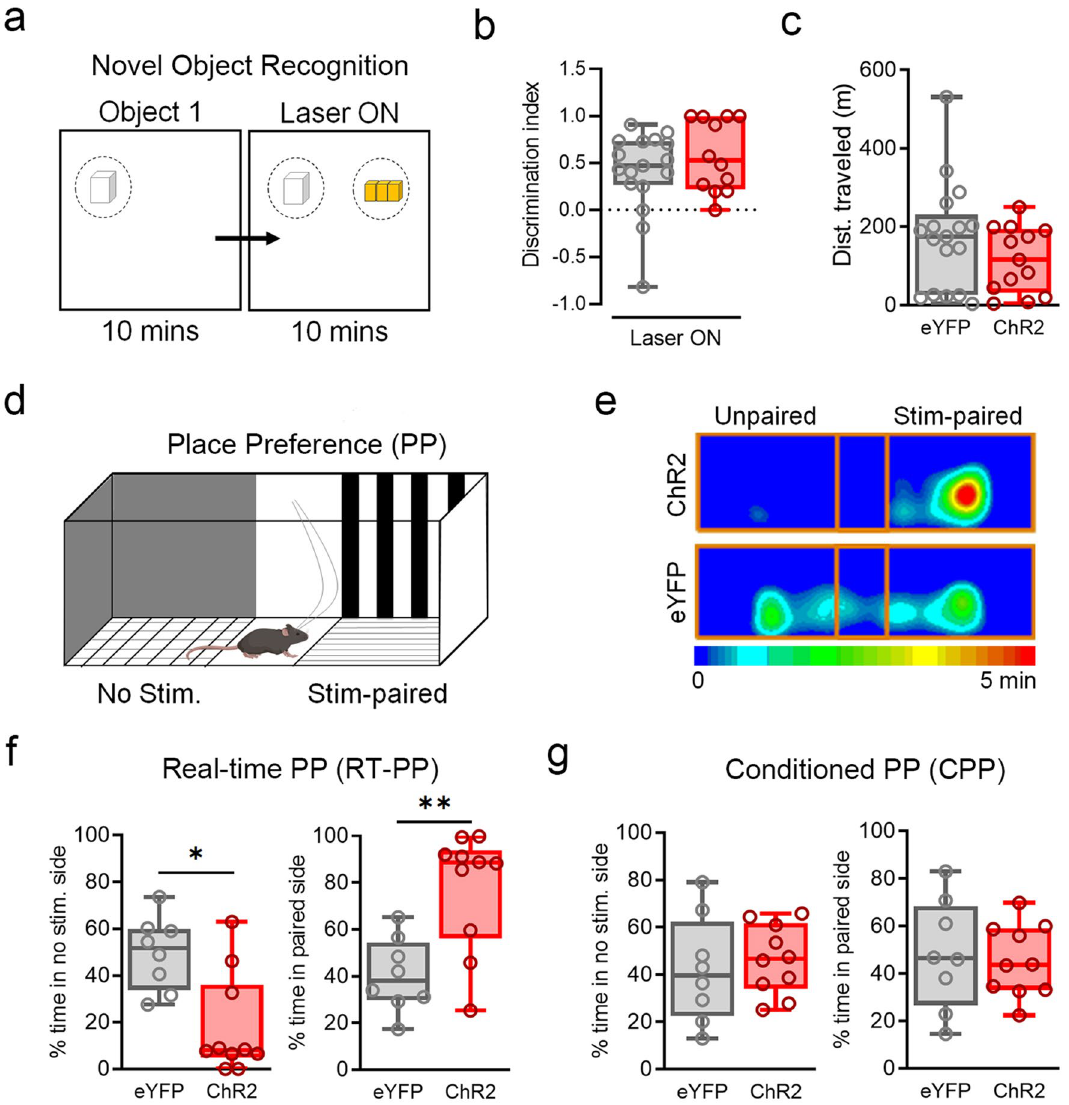
Figure 2. BF GAD2+ neuron activation does not affect exploration or object recognition and induces reward-like effects. ( a ) Design of novel object recognition test. ( b ) Discrimination index is measured as the time spent exploring the novel object—time spent exploring the familiar object divided by the total time exploring novel object and familiar object. ChR2, n = 12; eYFP, n = 17. ( c ) Total distance traveled during laser ON epoch. ChR2, n = 12; eYFP, n = 17. ( d ) Design for test of real-time and conditioned place preference. ( e ) Heatmap of center body location, of ChR2 and eYFP sample animal. ChR2, n = 10; eYFP, n = 8. ( f ) Real-time place preference, measured on day 1 during photostimulation. Percent time in unpaired side, Mann–Whitney test, U = 12, *p < 0.05. Percent time in stimulation paired side, Mann–Whitney test, U = 10, **p < 0.01. ChR2, n = 10; eYFP, n = 8. ( g ) Conditioned place preference, measured on day 2 in the absence of photostimulation. ChR2, n = 10; eYFP, n = 8. Schematics ( a , d ) were created using BioRender.com and